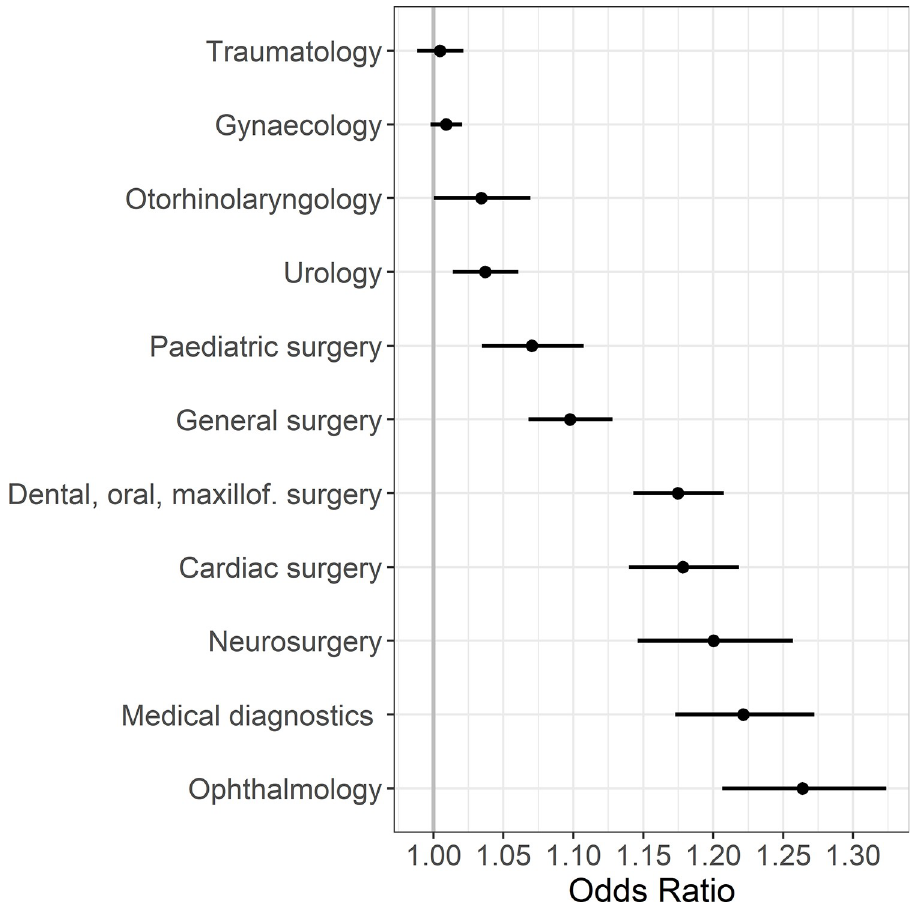
Fig 2. Odds ratios per year with 95% confidence intervals for supraglottic airway device use according to operative/medical specialty.